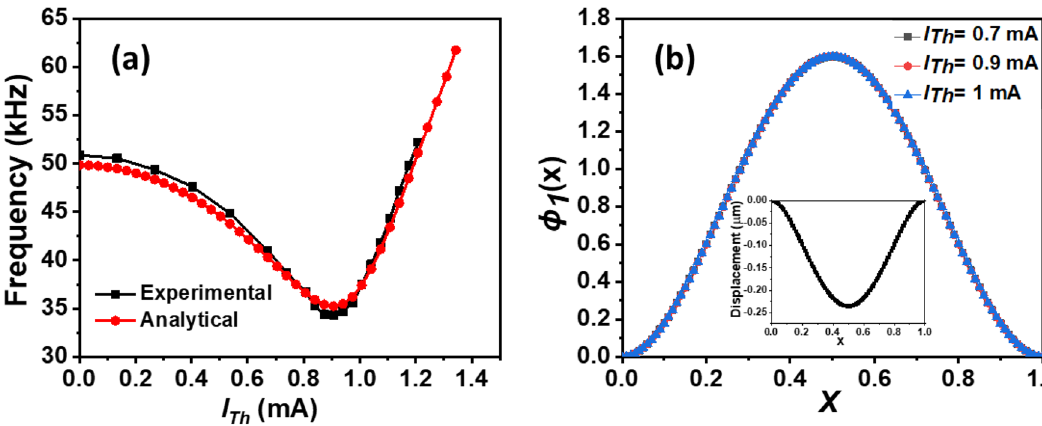
Figure 3. ( a ) Experimental and analytical results of the resonance frequency variation of the micro-beam with the electrothermal current I Th . ( b ) The simulated mode shape for V DC = 30 V and for various of I Th . The inset shows the analytical result of the static deflection of the micro-beam with V DC = 30 V and I Th = 0 frequency of the micro-beam while changing the electrothermal current I Th . Good agreement is shown among the results. It can be seen that the resonance frequency decreases with the increase of I Th until it reaches the buckling zone ( I Th = 0.91 mA). Within this range, the resonance frequency varies from 52 to 35 kHz, confirming that the presence of V DC causes perturbation around the buckling zone (imperfect buckling). Thus, the system shows a midpoint displacement of 0.25 μm (initial curvature), see the inset of Fig. 1a. Hence, operating around this zone, the micro-sensor is very sensitive to any stiffness change (for instance from the magnetic distributed forces). After the imperfect buckling zone, the resonance frequency increases due to the induced curvature of the micro-beam. To further investigate the dynamic response of the system with I Th , we plot the mode shapes of the micro- beam for V DC = 30 V and for various I Th , Fig. 3b. It is clear that, before the buckling point, there is no effect of the compressive axial load on the mode shapes.